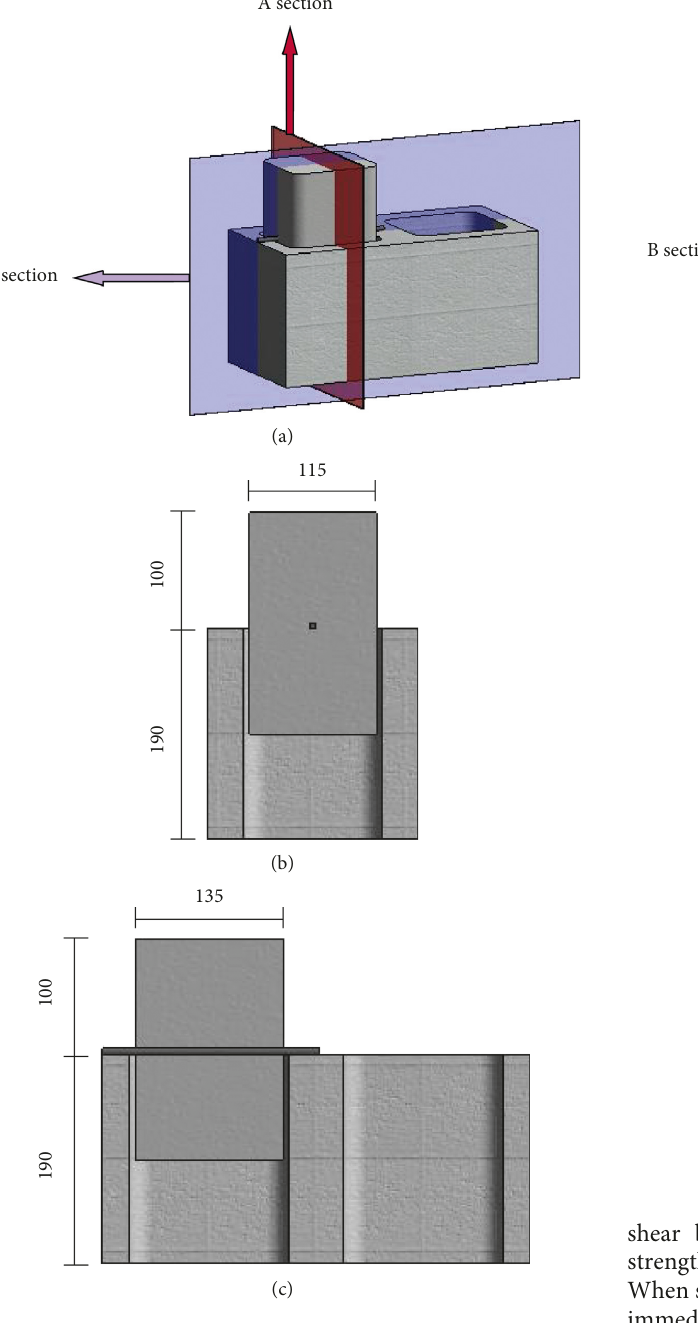
Figure 1: PB-H/2.